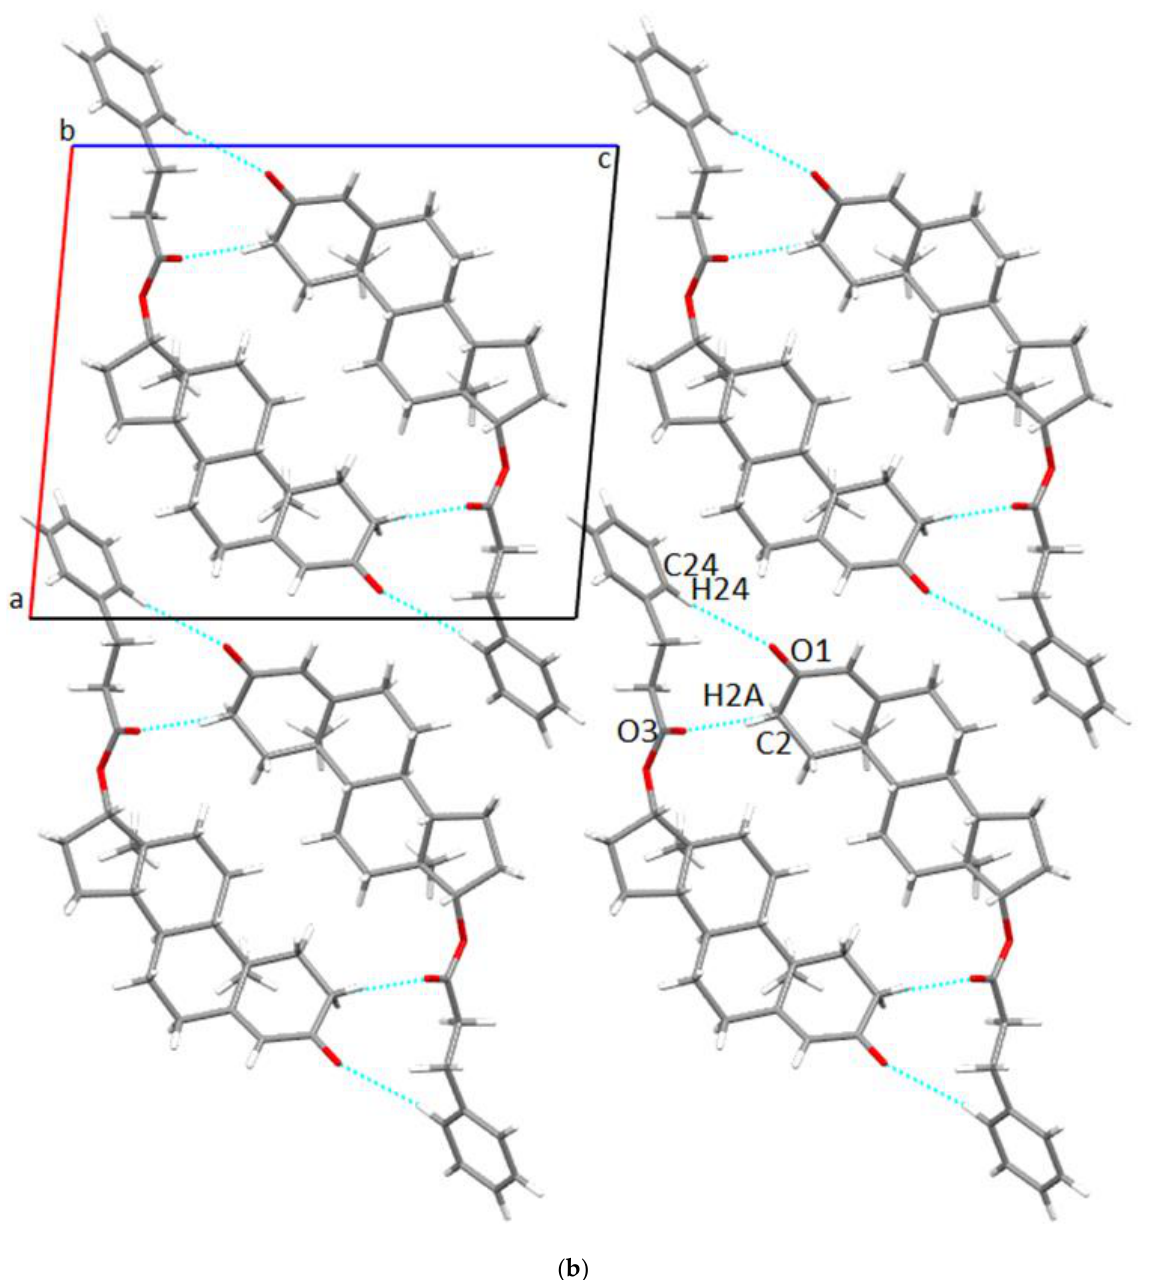
Figure 4. Asymmetric unit of TPhp presenting nonhydrogen atoms at 50% probability level ( a ) and overall packing diagram along b-axis ( b ) .